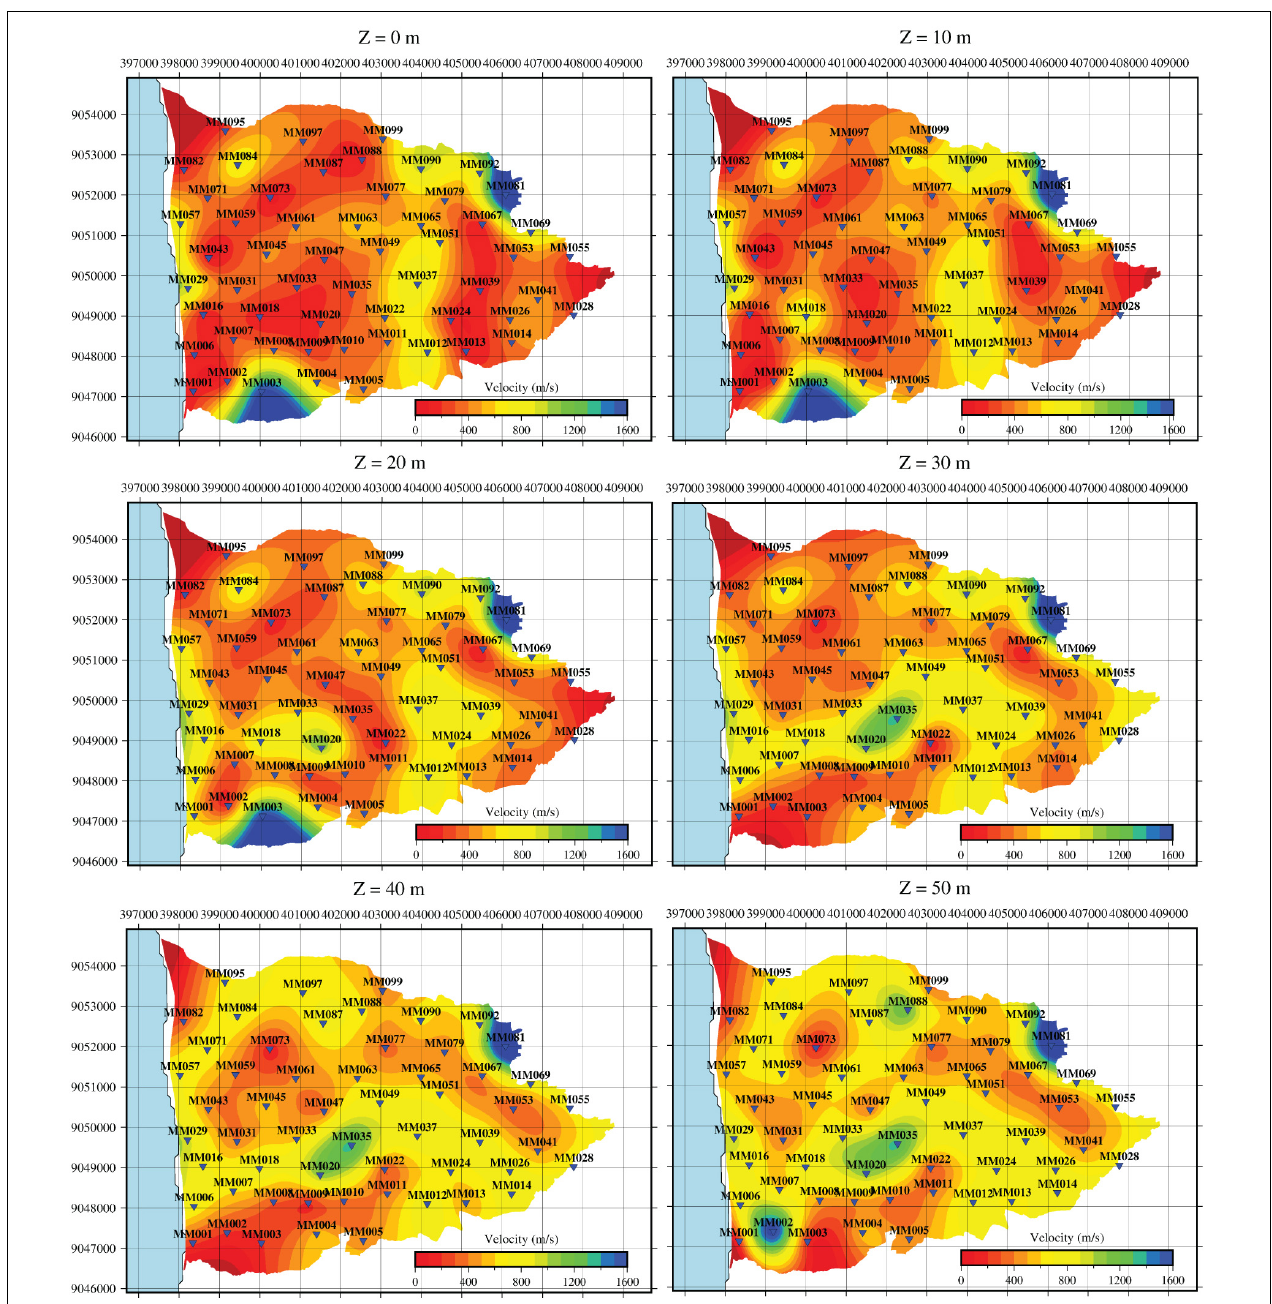
FIGURE 11 | The horizontal cross-section of Vs structure in Mataram City from depths 0–50 m. The depth of each cross-section is displayed on top of the corresponding cross-section.